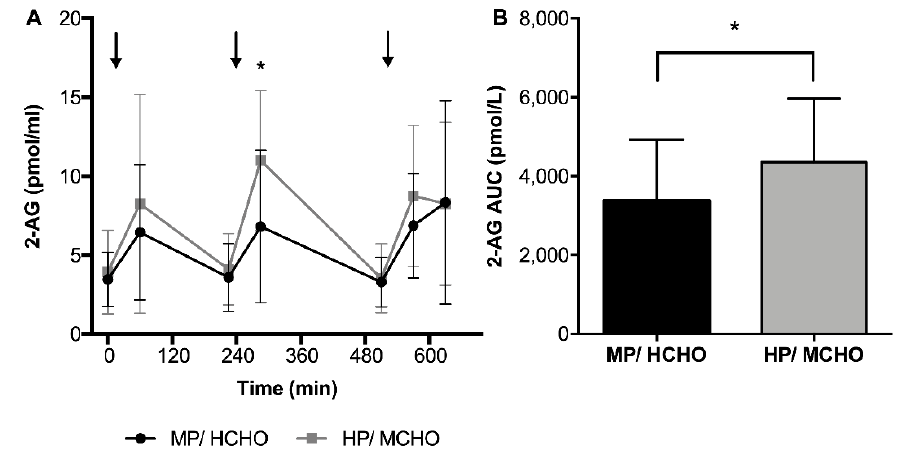
Figure 2. ( A ) Postprandial responses and ( B ) area under the curve (AUC) of 2-AG in the MP / HCHO (black) and HP / MCHO (grey) group. Arrows indicating timepoint of meals. Values are means ± SD. MP / HCHO = moderate protein / high carbohydrate; HP / MCHO = high protein / moderate carbohydrate; 2-AG: 2-arachidonoylglycerol. * p < 0.05.